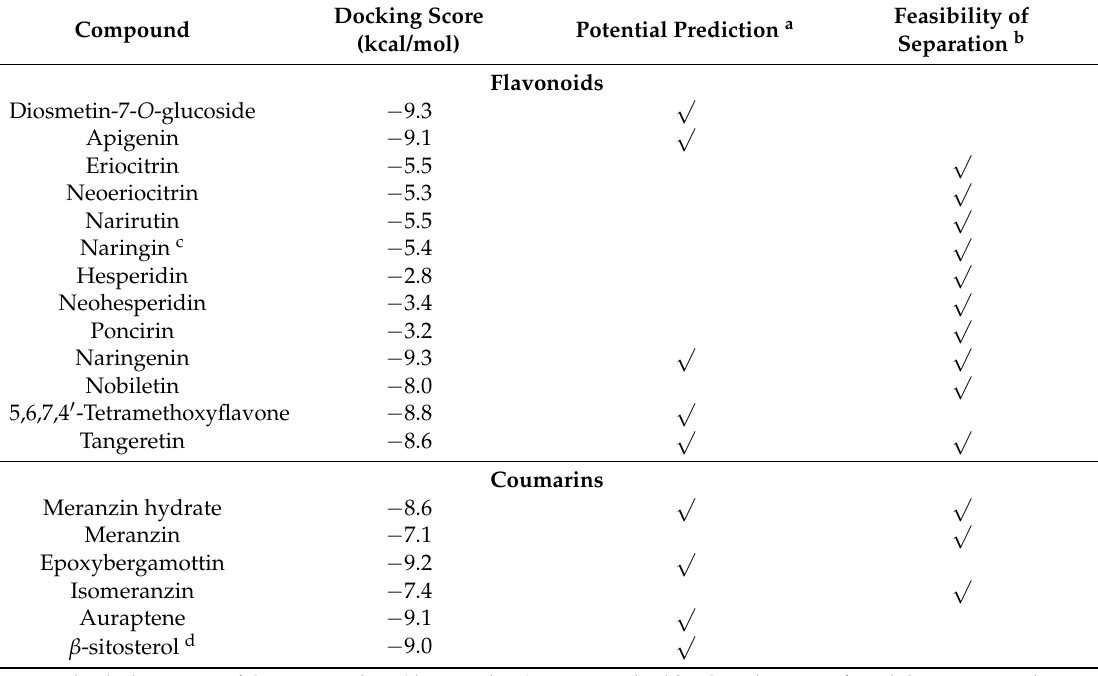
Table 1. Screened potential antagonists of D 2 dopamine receptor (D 2 R) from Aurantii fructus (AF) by the use of docking score, potential prediction, and feasibility of preparative separation. Feasibility of Docking Score Compound Potential Prediction a Separation (kcal/mol)